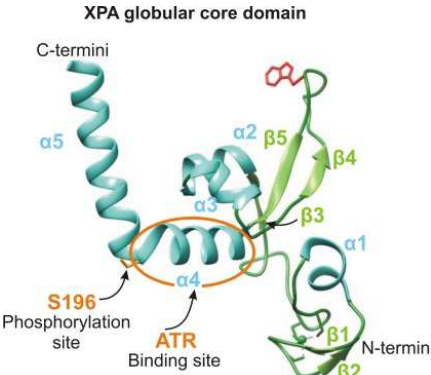
Figure 6. The ATR interaction site on XPA is the α4-helix located on the N-terminal side of the α4-helix-turn-α5-helix motif. ATR phosphorylates XPA at serine 196 (S196), which is located in the “turn” element inside the helix-turn-helix motif. The color codes correspond to Figure 1A. The structure was generated using UCSF Chimera software (version 1.16).